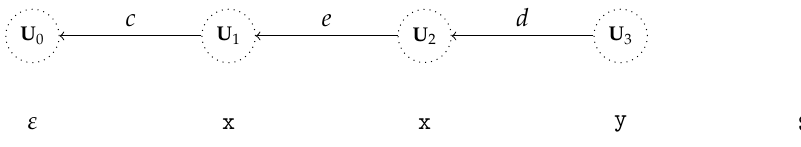
Figure 9. Zoomed-out view of the GSS for the specification Ξ in (2) only displaying the edges resulting from shift